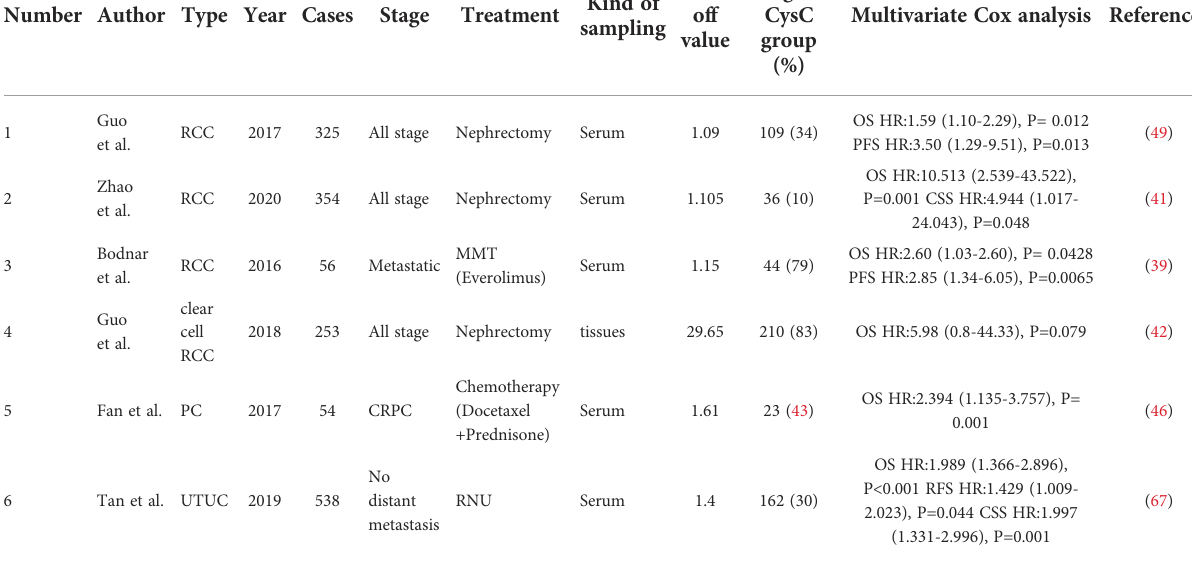
Number Author Type Year